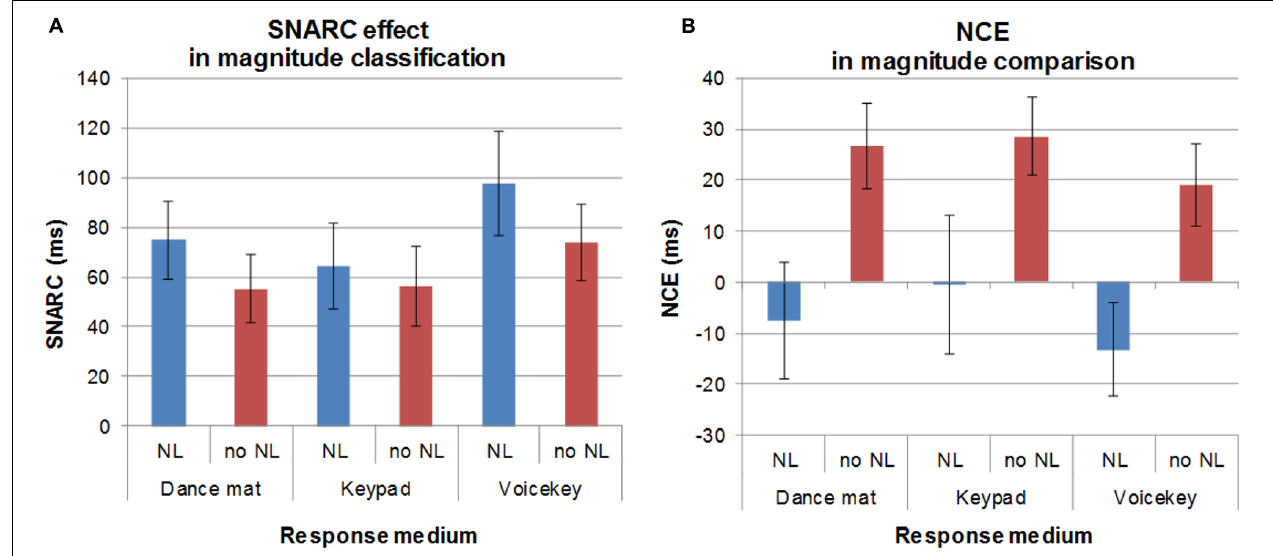
FIGURE 2 | Mean effects of spatial-numerical associations in each condition in the magnitude classification task (fixed standard) measuring the SNARC effect (A) and magnitude comparison task (variable standard) measuring the NCE (B) . Error bars represent ± 1 SEM.